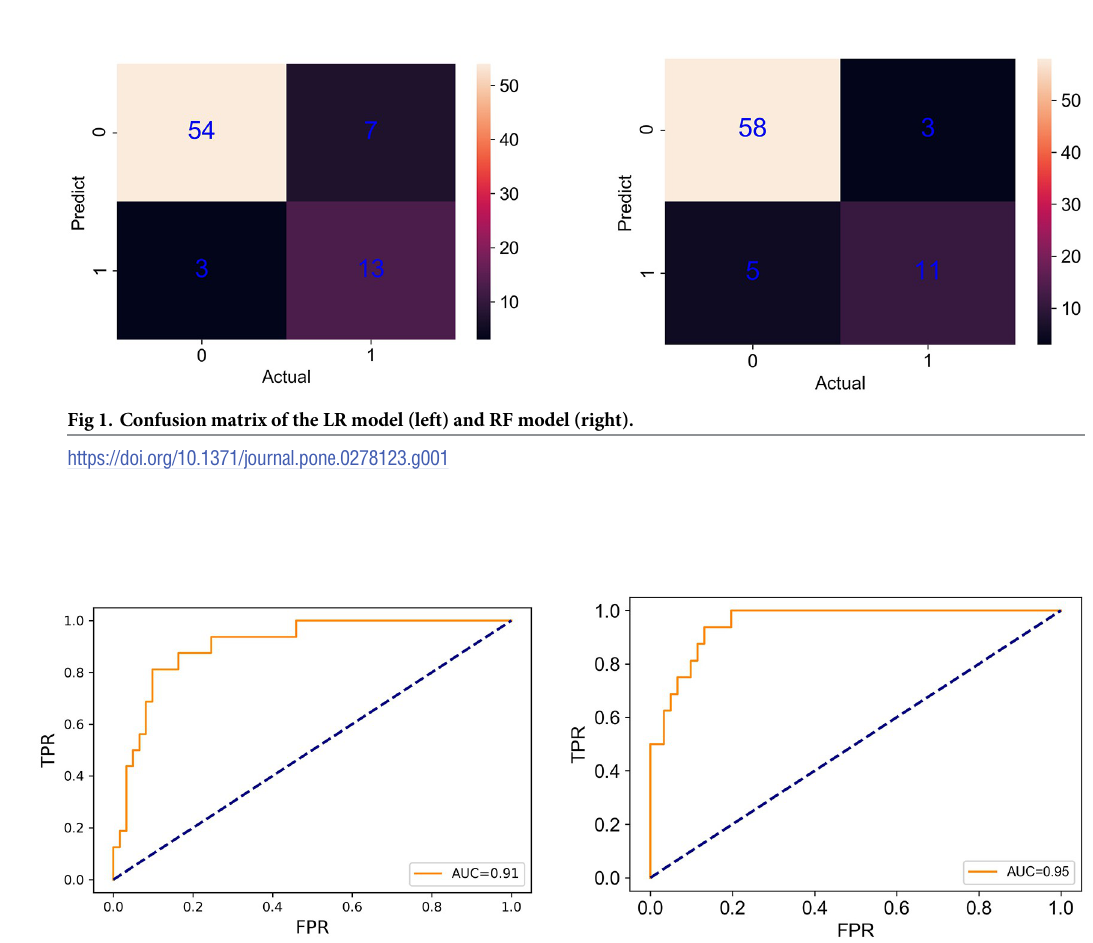
Fig 2. The ROC curves for the LR model (left) and RF model